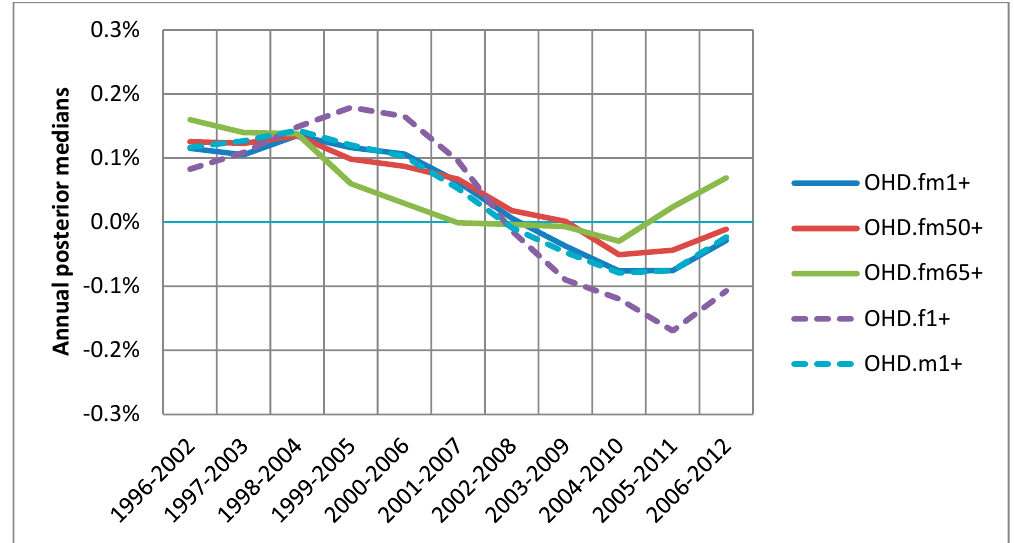
Figure 6. Annual associations between warm season 1-day lagged ozone and OHD hospitalizations for 5 groups: base group (fm1+) in solid blue; over50 group, (fm50+) in solid red; seniors (fm65+) in solid green; females aged ≥ 1 (f1+) in dashed purple; and males aged ≥ 1 (m1+) in dashed blue.